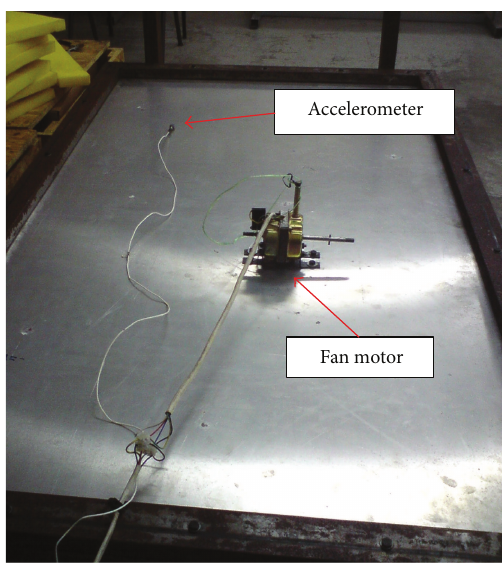
Figure 5: The fan motor attached on the high mobility reception plate.